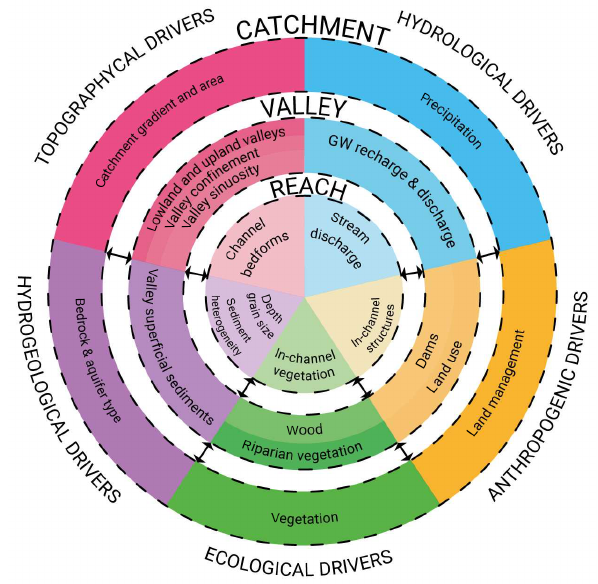
Figure 2. Conceptual diagram of the key drivers of the hyporheic exchange across scales. This diagram can be read from the centre to the outer part and vice versa, as indicated by the black arrows. Dashed lines represent hidden boundaries between scales. Colour gradient, from light to dark, follows the hierarchical approach of this review from the channel scale to the reach scale to the catchment